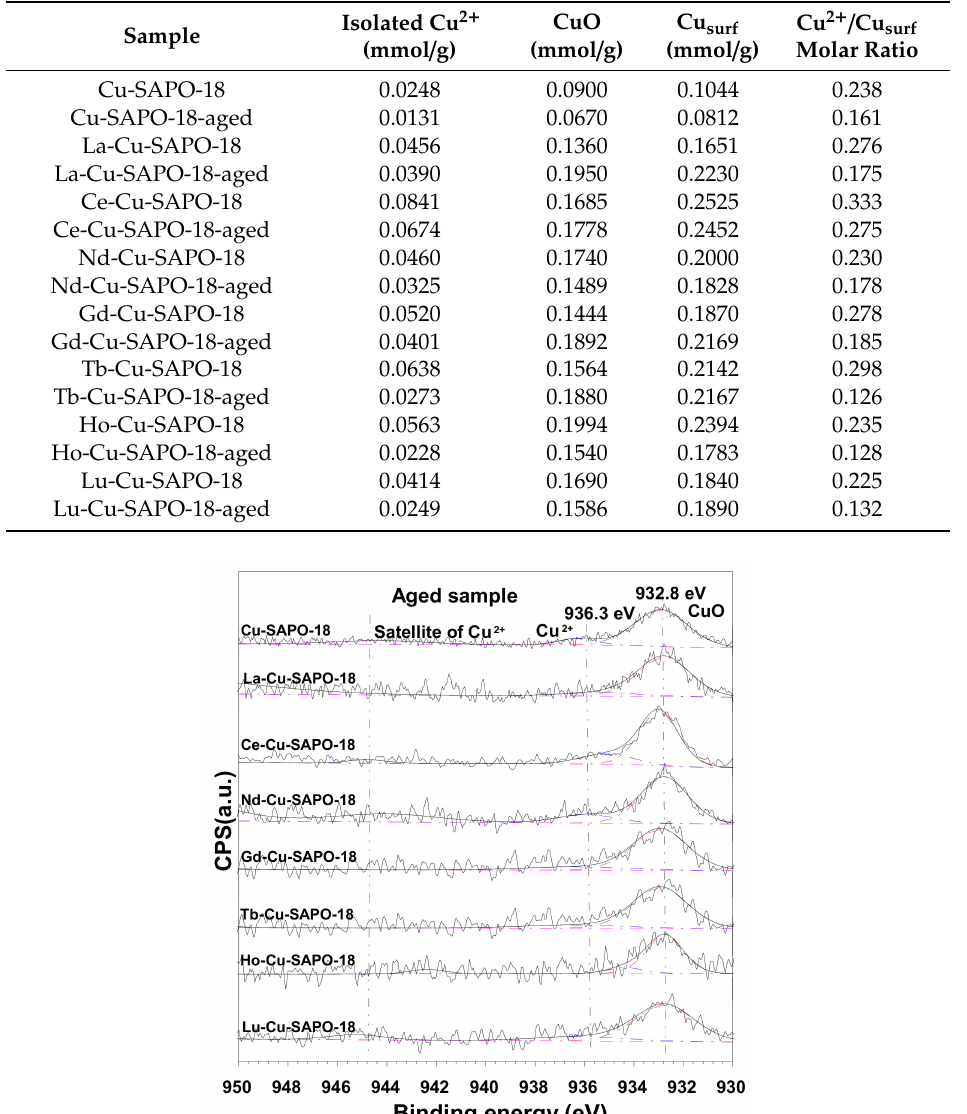
Table 2. Cu2p 3 / 2 XPS Curve-Fitting Results on the Surface of Cu-SAPO-18 and M-Cu-SAPO-18 Samples Before and After Hydrothermal Aged Treatment.